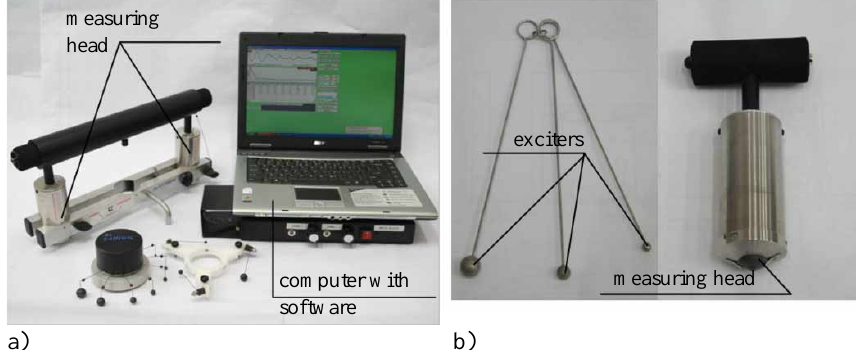
Fig. 3. Idea of impact-echo technique: (a) measuring set; (b) exciters and measuring